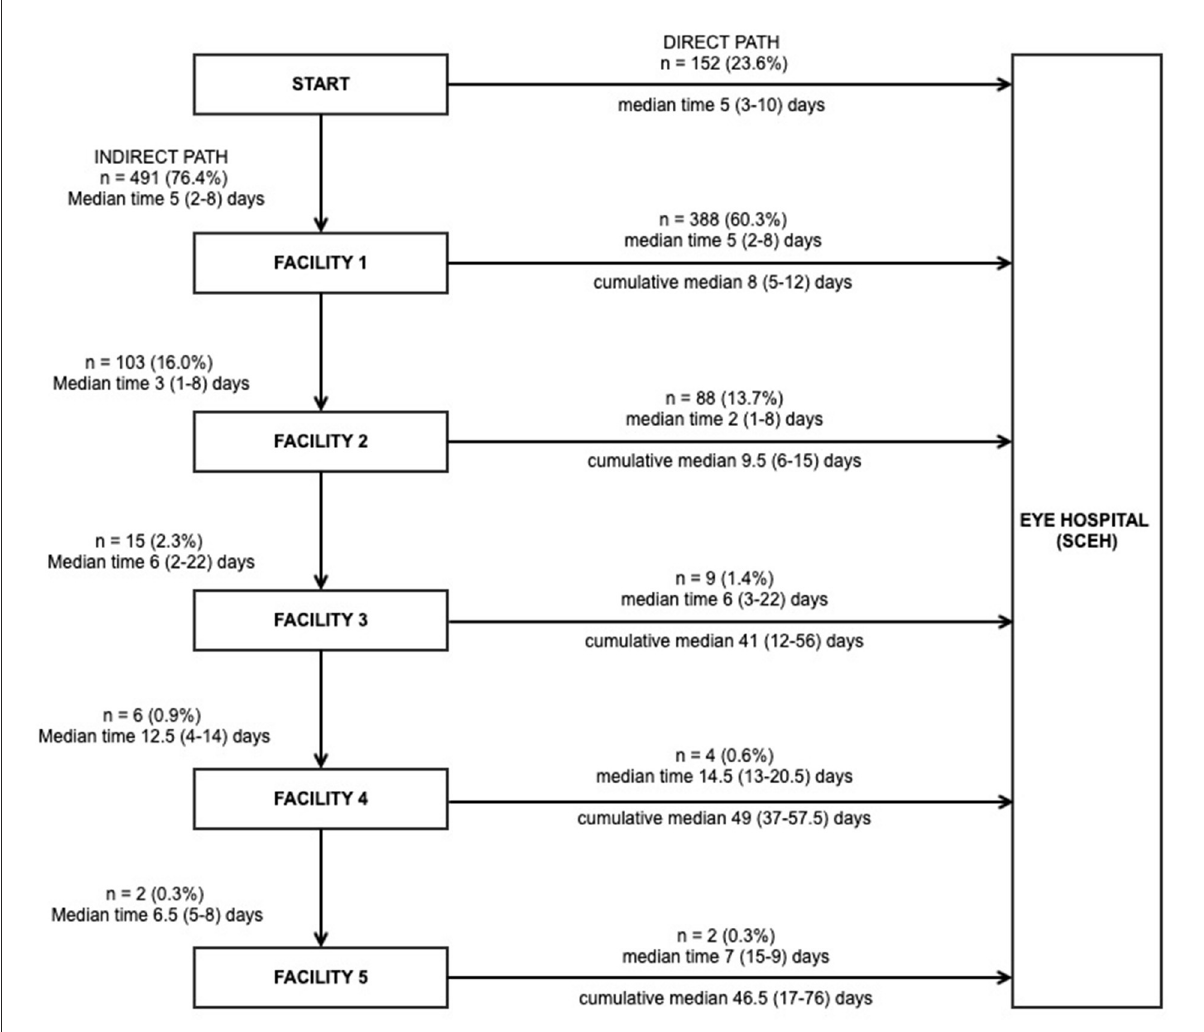
FIGURE2 The care-seeking journey of patients with microbial keratitis, the time taken at each stage, and the cumulative time from onset of symptoms to presentation ( n = 643). Note all patients returned home after attending each facility, from where they restarted any subsequent journeys, apart from the following exceptions: (1) Journey 2: one patient referred directly from a private clinic to a private hospital; seven patients referred directly from a satellite eye care clinic (ECC) to Sagarmatha Choudhary Eye Hospital (SCEH); (2) Journey 3: 19 patients referred directly from ECC to SCEH. Six patients attended SCEH as their first facility but did not receive a definitive diagnosis and/or treatment at that point and all had to make one additional journey to SCEH for final definitive